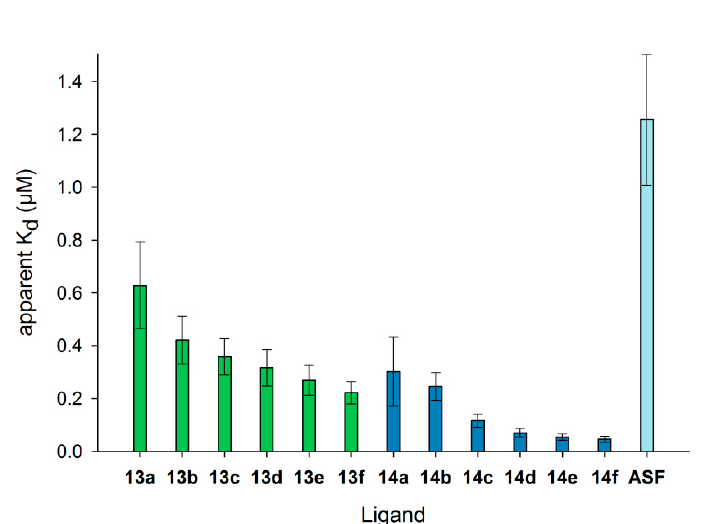
Figure 5. Apparent K d values of Gal-3 for binding to immobilized neo-glycoproteins. The Gal-3 concentration (µM) at half-maximal binding (K d ) is shown for the different neo-glycoproteins 13a – f ( ■ ) and 14a – f ( ■ ), as well as ASF ( ■ ). K d values decreased with increasing modification degree, indicating higher affinity of human Gal-3 (see Table S3 in the Supplementary